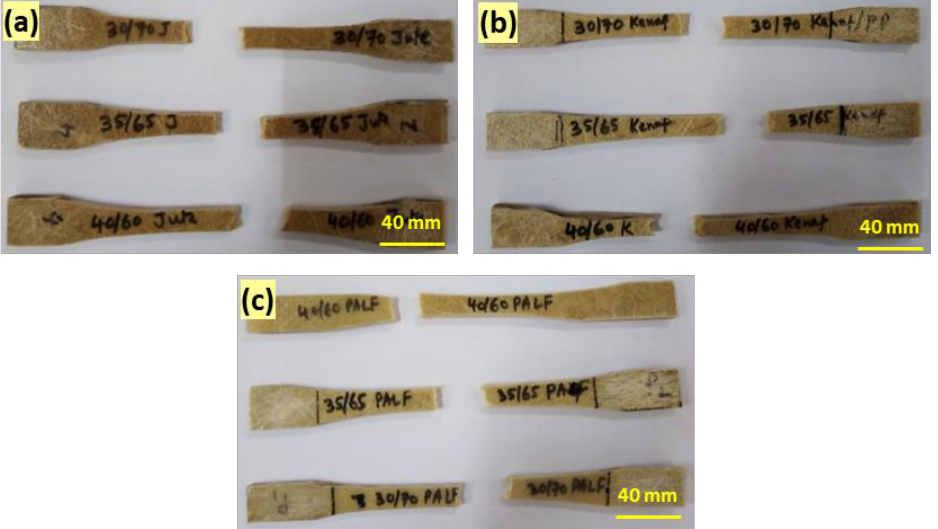
Figure 5. Tensile testing of composite specimens with ( a ) jute, ( b ) kenaf, and ( c ) PALF fibers.